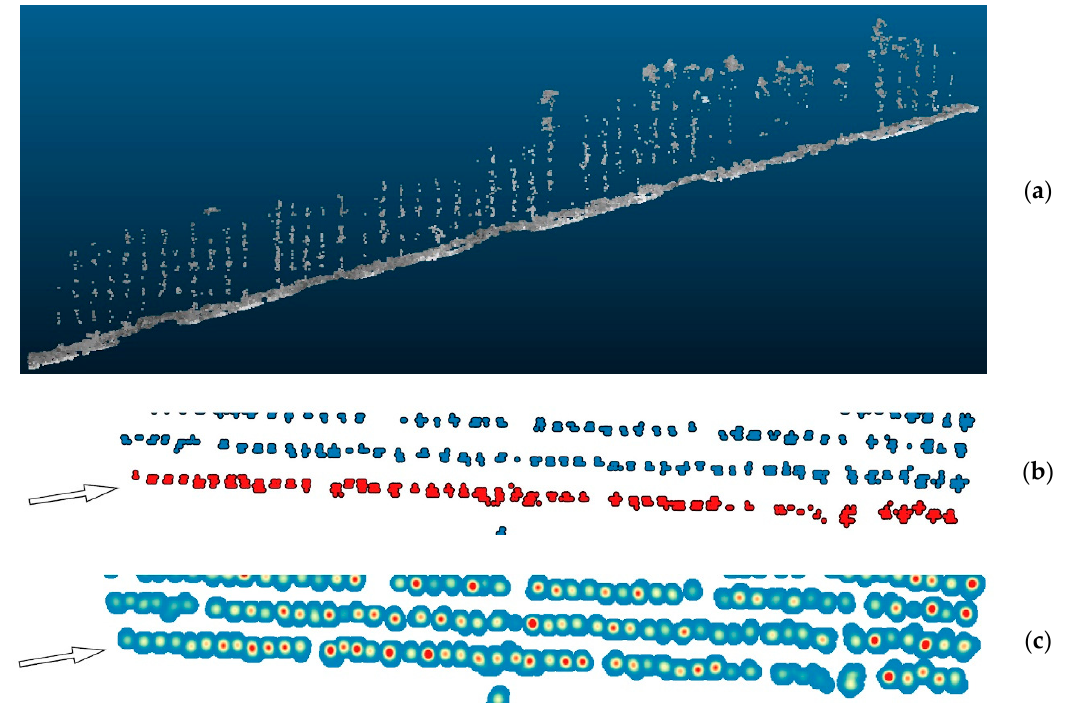
Figure 4. Overview of Method 1 and Method 2 creation steps: ( a ) point cloud of a sample row of trees; ( b ) dissolve applied to overlapping polygons obtained by buffering stem points; ( c ) standardized density grid on the horizontal projection of the points.